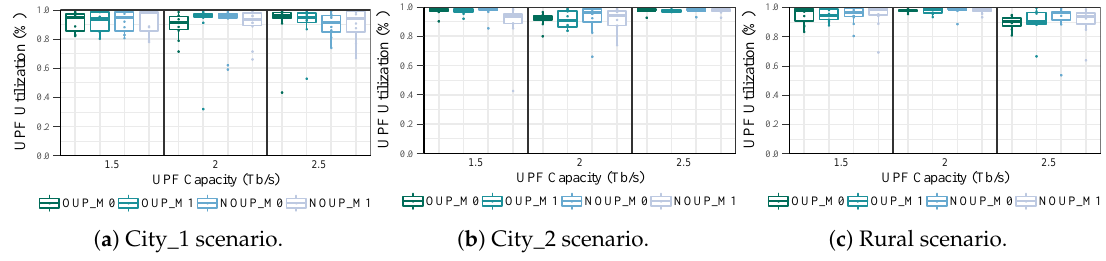
Figure 10. UPF Utilization vs. capacity for services with low requirements.